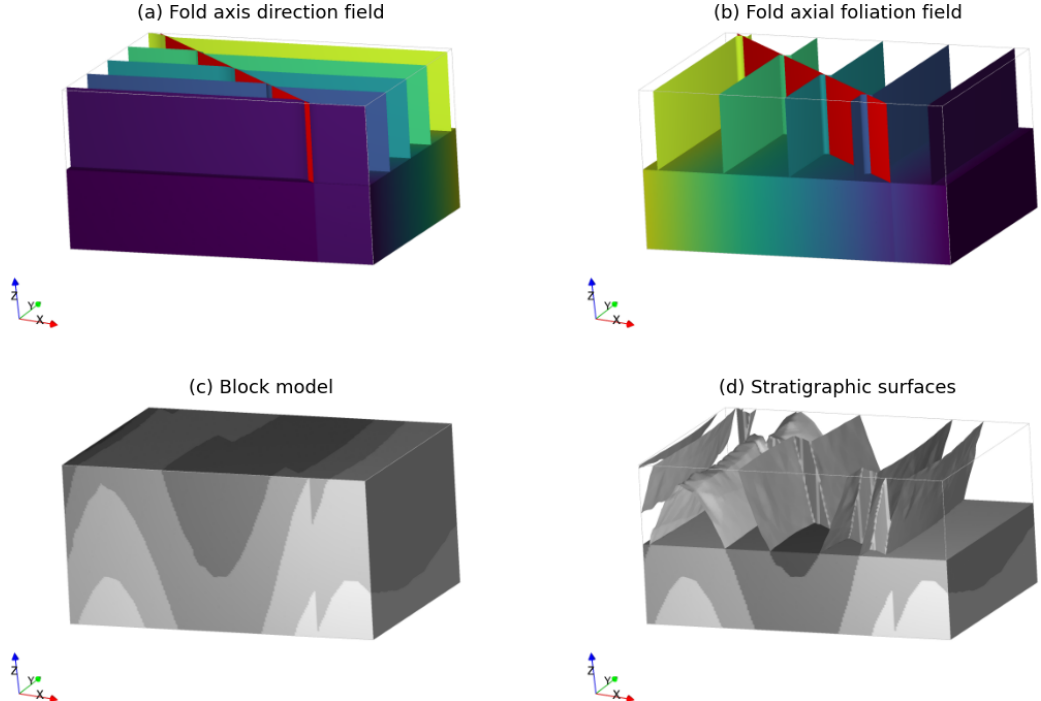
Figure 12. Example integrating fault kinematics and fold modelling from Laurent et al. (2016) and Grose et al. (2017). (a) Fold frame axial foliation scalar field. (b) Fold frame fold axis direction scalar field. Corresponding fold S plots are shown in Fig. 11. (c) Scalar field showing bedding interpolated using fold constraints with the fault added to the interpolator. (d) Surfaces extracted from the geological model in (c) including the fault